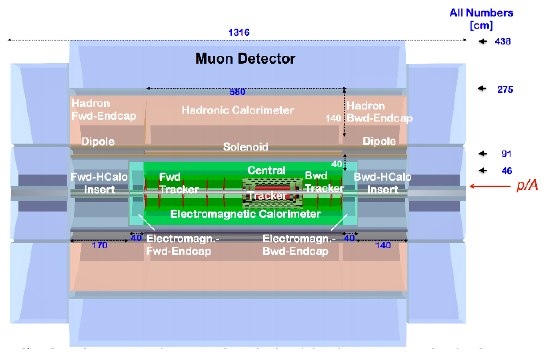
Figure 1 . Possible layout of the LHeC detector, (cid:12)gure from